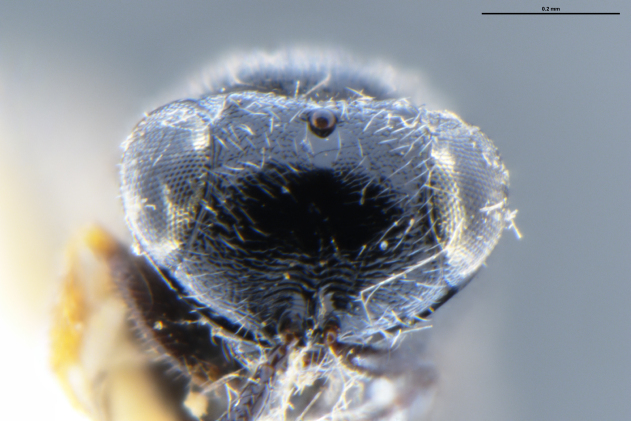
head, anterior view